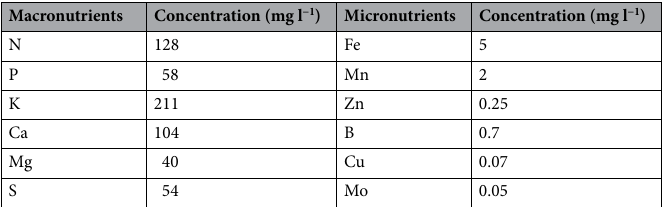
Table 1. Concentration of nutrients used in the nutrient solution of this experiment.